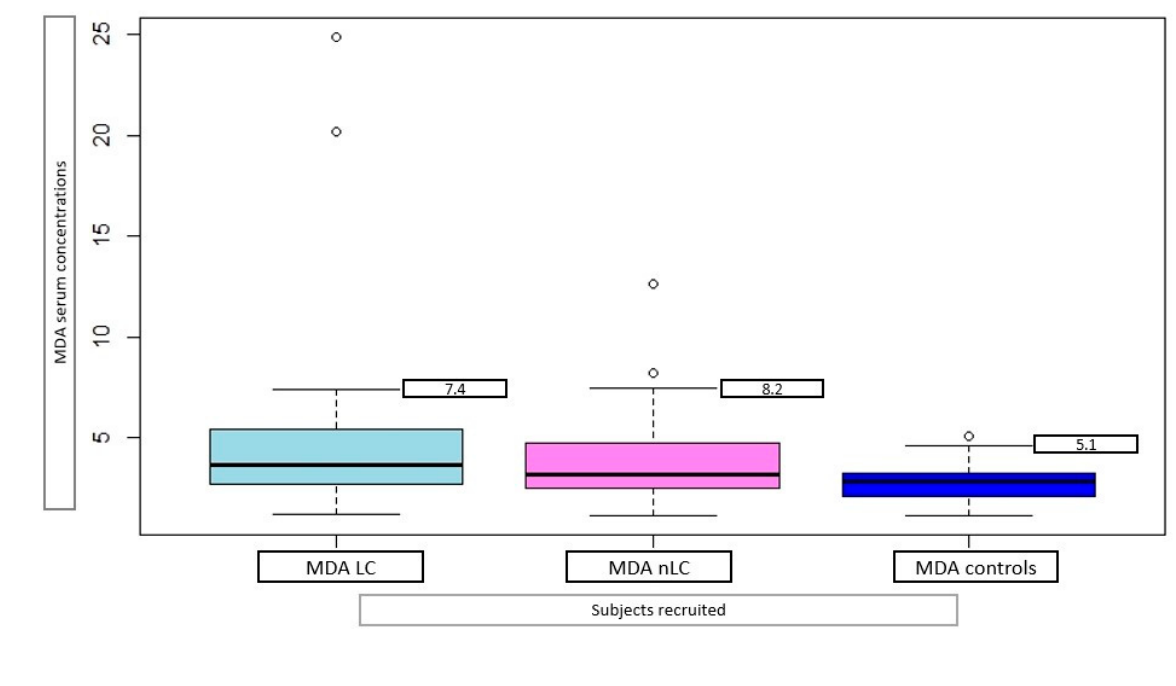
Table 2. A higher prevalence of the female sex and patients requiring oxygen therapy dur- ing the acute infection was found in the LC than in nLC patients (19% vs. 6%, and 4% vs. 0%, respectively, p < 0.001). In addition, this group had signi fi cantly higher IgG values and lower mean hematocrit values than the nLC patients (Table 2).